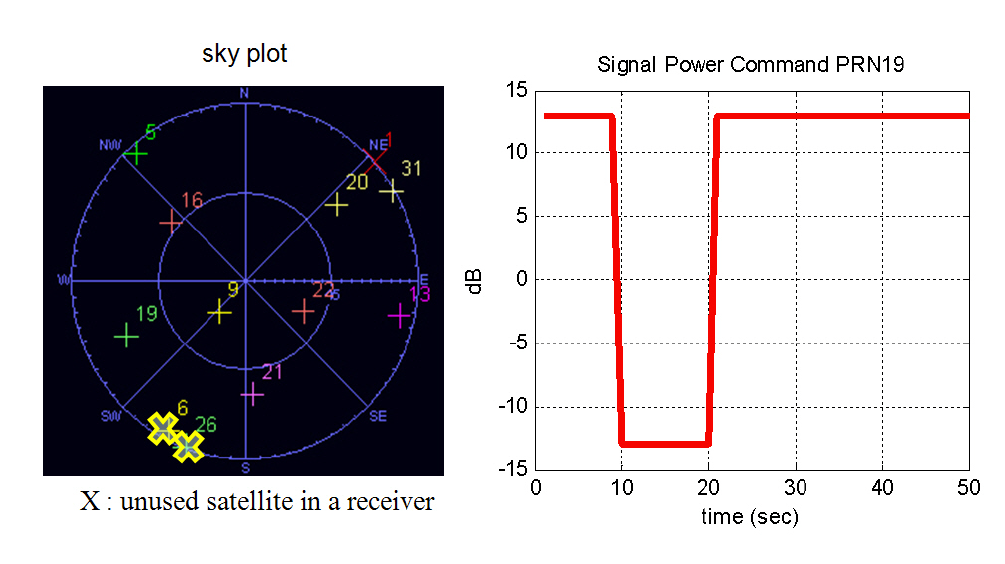
Figure 10. Sky plot (left) and signal power command on PRN 19 (right), (PRN 6 and PRN 26 are not used because of their low elevation